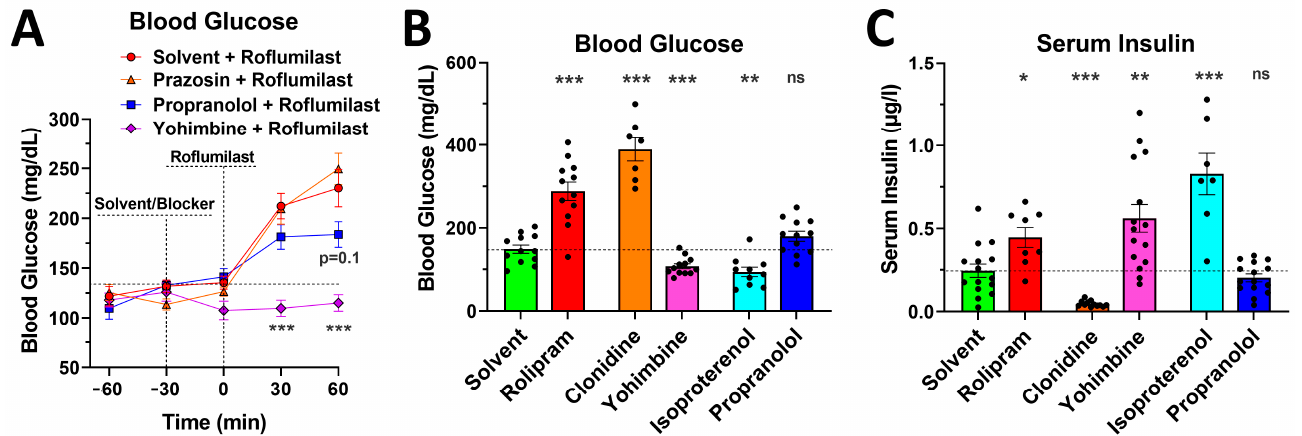
Figure 5. Pretreatment with the β -blocker propranolol or the α 2 -adrenoceptor blocker yohimbine alleviates the glycemic effects of PAN-PDE4 inhibition. ( A ) Postprandial mice were injected (i.p.) with the β -blocker propranolol (5 mg/kg), the α 1 -adrenoceptor blocker prazosin (1 mg/kg), the α 2 -adrenoceptor blocker yohimbine (5 mg/kg), or solvent controls, followed 30 min later with an injection of the PDE4 inhibitor roflumilast (5 mg/kg), in all mice. Blood glucose levels measured at tail pricks are shown at the indicated time points. ( B , C ) Postprandial mice were injected with the PDE4 inhibitor rolipram (5 mg/kg), the α 2 -adrenoceptor agonist clonidine (1 mg/kg), the α 2 -adrenoceptor blocker yohimbine (5 mg/kg), the β -agonist isoproterenol (5 mg/kg), the β -blocker propranolol (5 mg/kg), or solvent controls, followed 60 min later by the measurement of blood glucose levels at tail pricks ( B ) and subsequent cheek bleeds to assess serum insulin levels via an ELISA ( C ). All data represent the mean ± SEM. Statistical significance was determined using the Mann–Whitney test (bar graphs) or a two-way ANOVA with Sidak’s post hoc test (time courses), and is indicated as ns ( p > 0.05); * ( p < 0.05); ** ( p < 0.01); and *** ( p < 0.001).